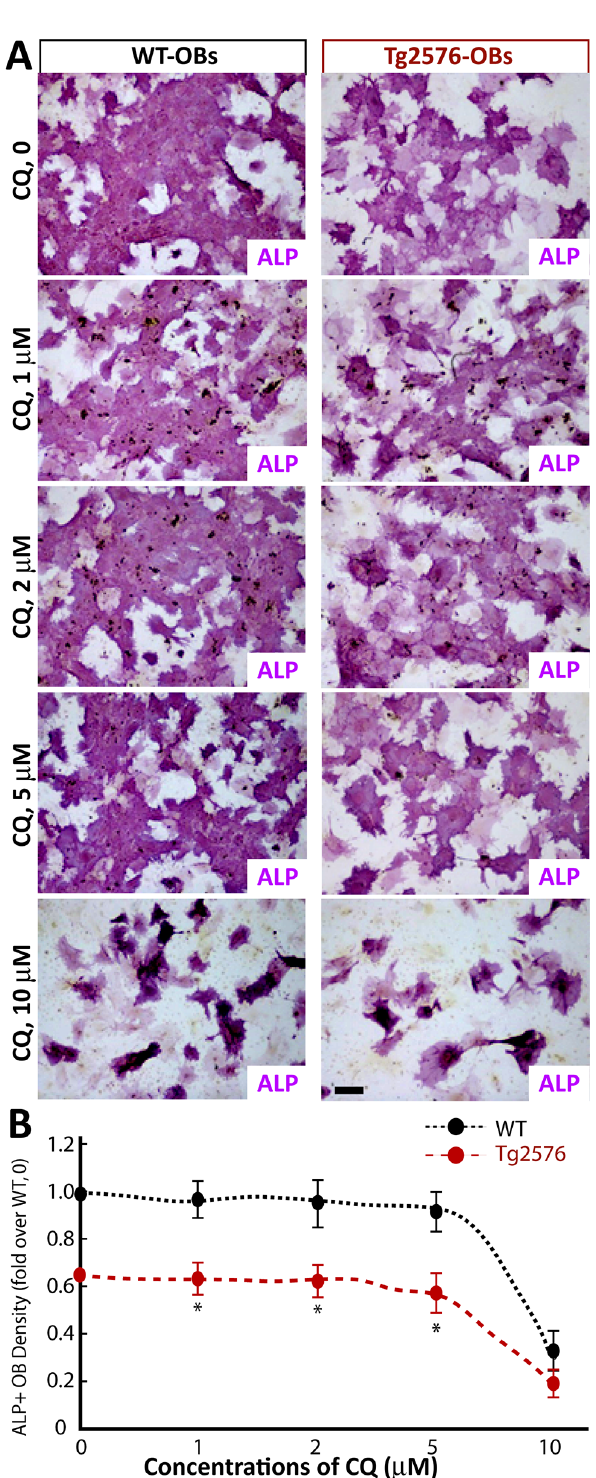
Fig 4. CQ effects on in vitro OB genesis. BMSCs from WT and Tg2576 mice were induced for OB differentiation in the presence of various concentrations of CQ. At day 7, cells were stained for ALP as described in the Methods. A, Representative images. B, Quantitative analyses. Note that lower concentrations ( < 5 microM) of CQ had little to no effect on ALP activity or OB differentiation. The values of mean ± SD from 3 separate cultures were